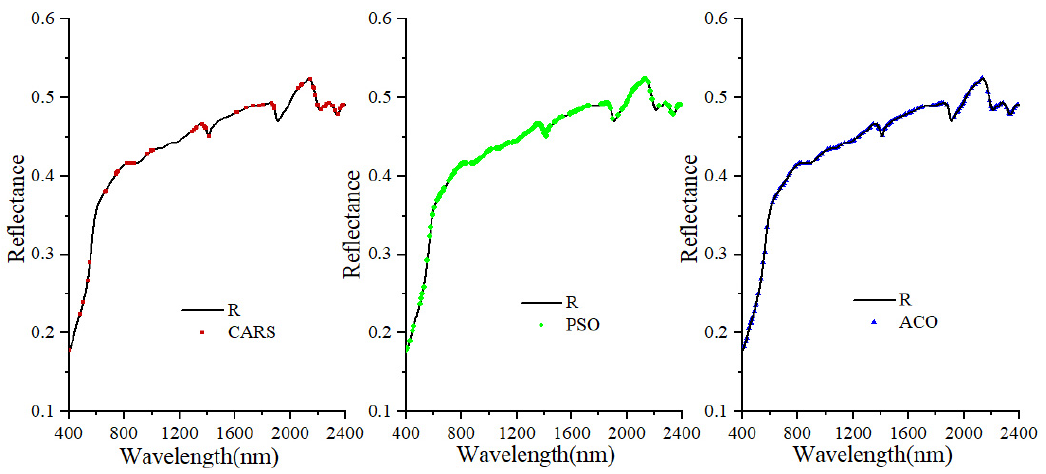
Figure 3. Filtered feature bands based on different algorithms.